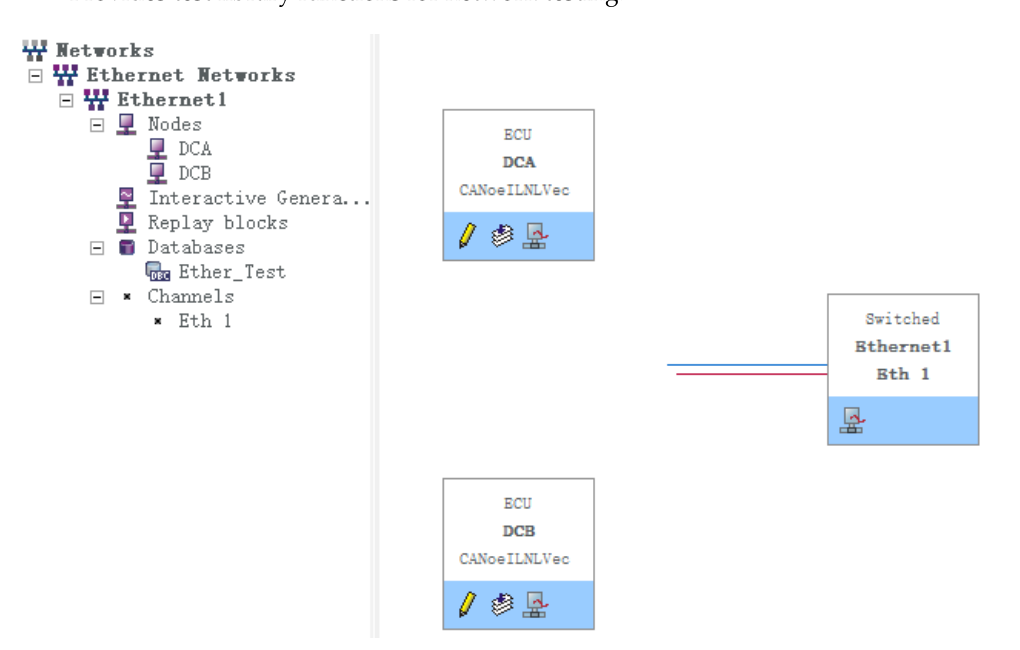
Figure 14. Protocol emulation environment.